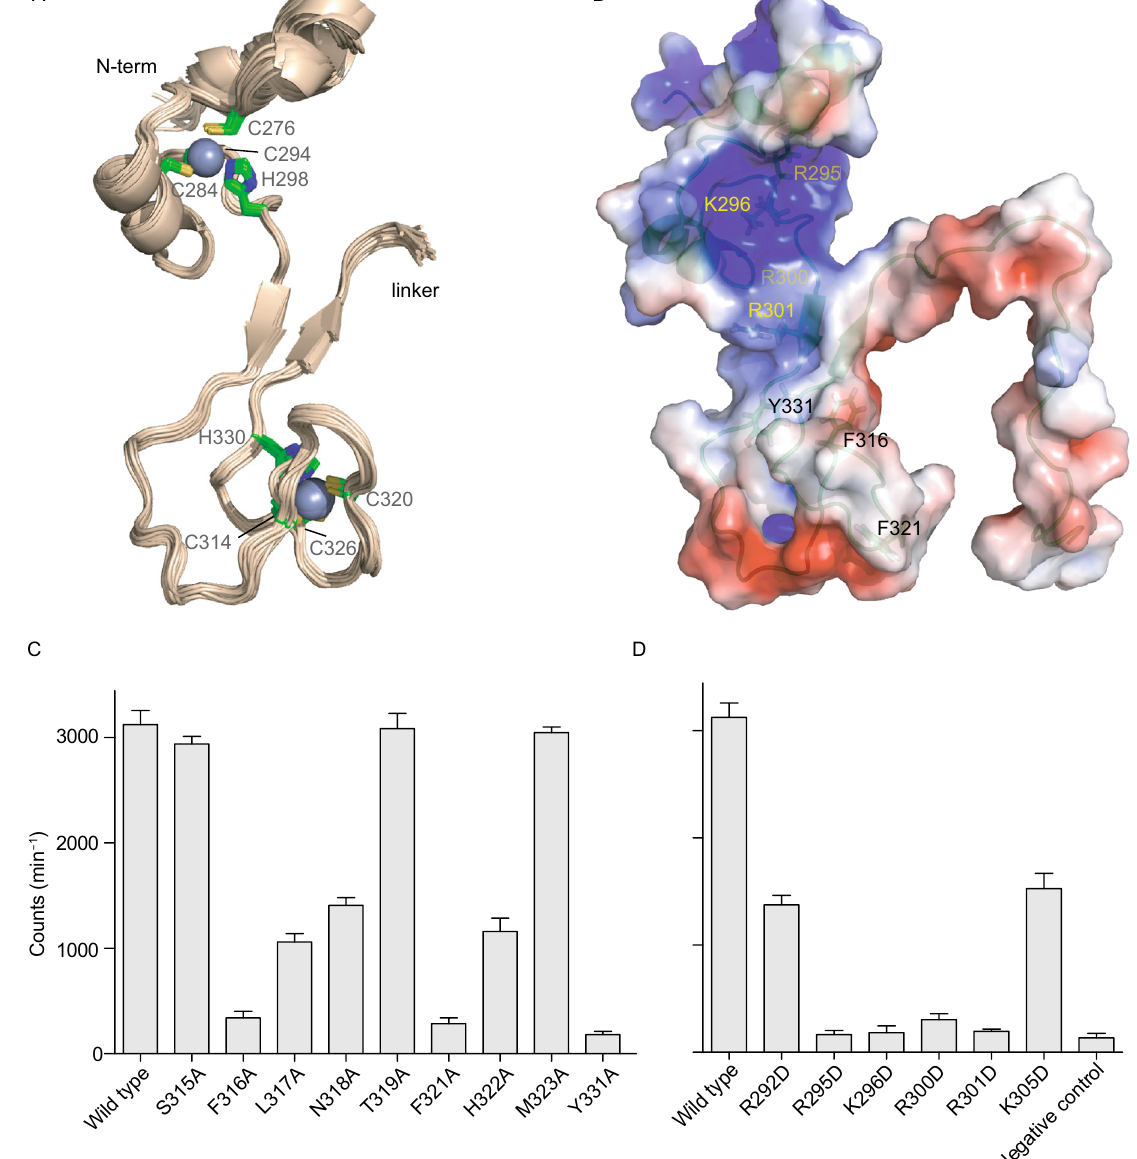
Figure 5. Solution structure of METTL3 ZFD. (A) Superposition of 25 lowest-energy structures of the ZFD. The structures were superimposed by backbone heavy atoms for residues 276 – 336, and the last 20 fl exible residues are not shown. Zn 2+ ions are shown as spheres, and the coordinating residues are shown as sticks. (B) Electrostatic potential colored surface, on a scale from red ( − 3 kT/ e) to blue (+4 kT/e), with the functionally important basic residues (yellow labels) and hydrophobic residues (black labels) denoted. (C) Methyltransferase activities for the METTL3-METTL14 heterodimers harboring point mutations to the hydrophobic residues.